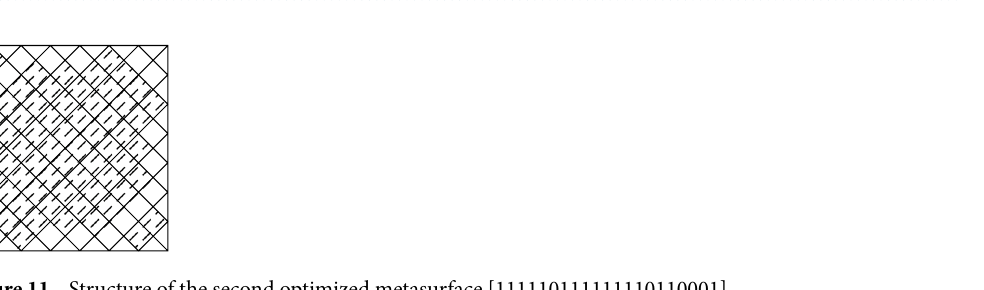
Figure 10. PCR of the first structure for different relaxation times of graphene.